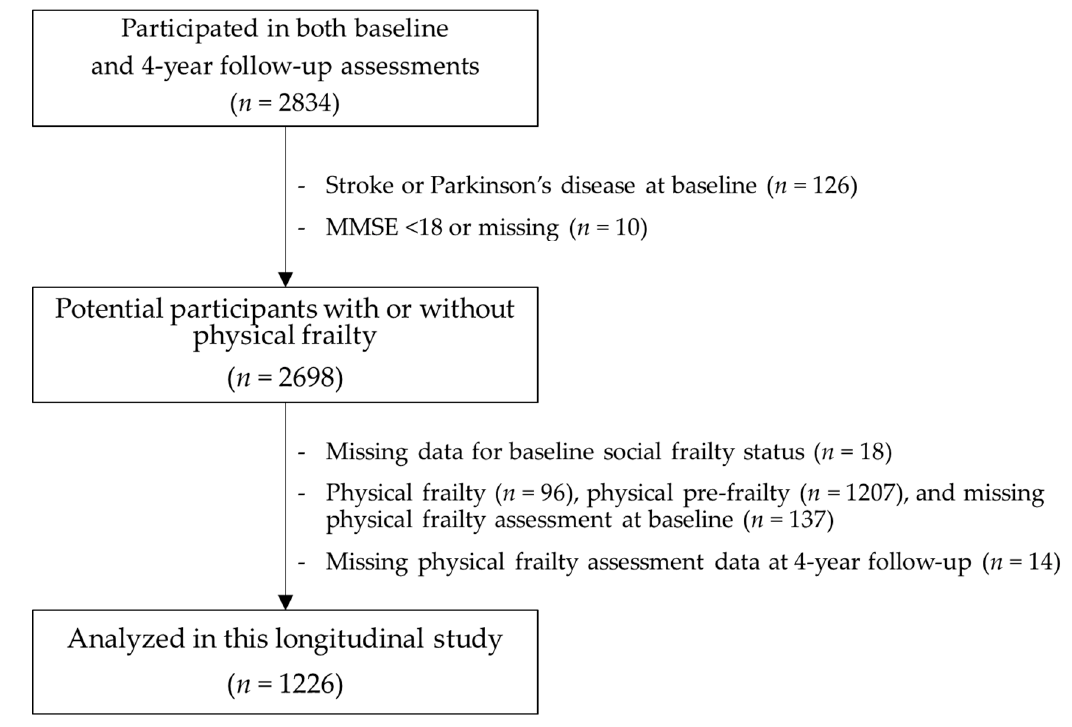
Figure 1. Participant inclusion criteria flow diagram. MMSE: Mini-Mental State Examination.